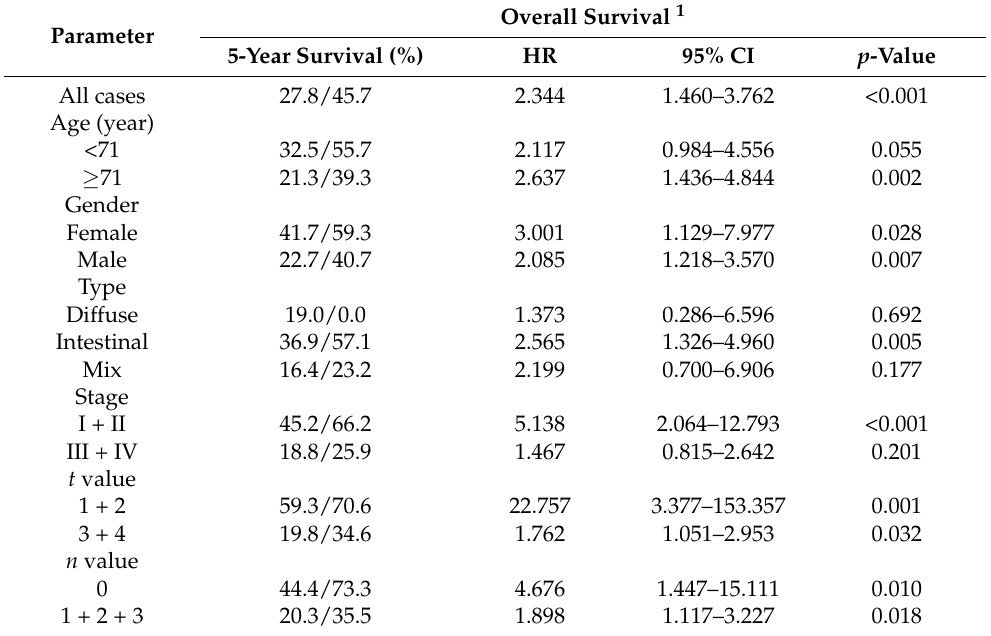
Table 4. Multivariate analysis of the influence of KFL10 expression according to clinical parameters on overall survival in gastric cancer